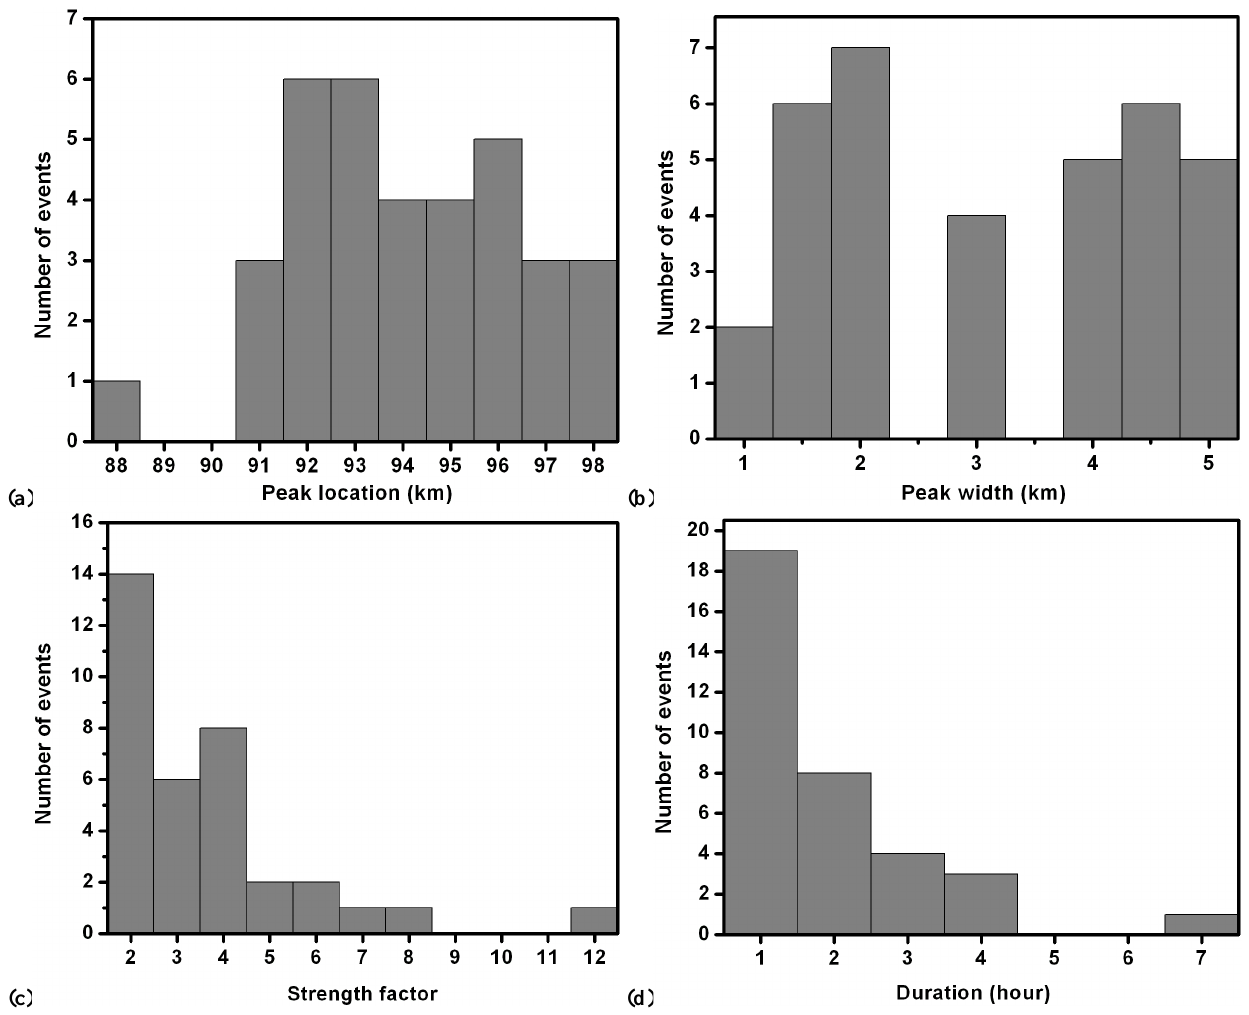
Fig. 4. Histograms of (a) peak location (b) peak width (c) strength factor and (d) duration of 35 SSL events